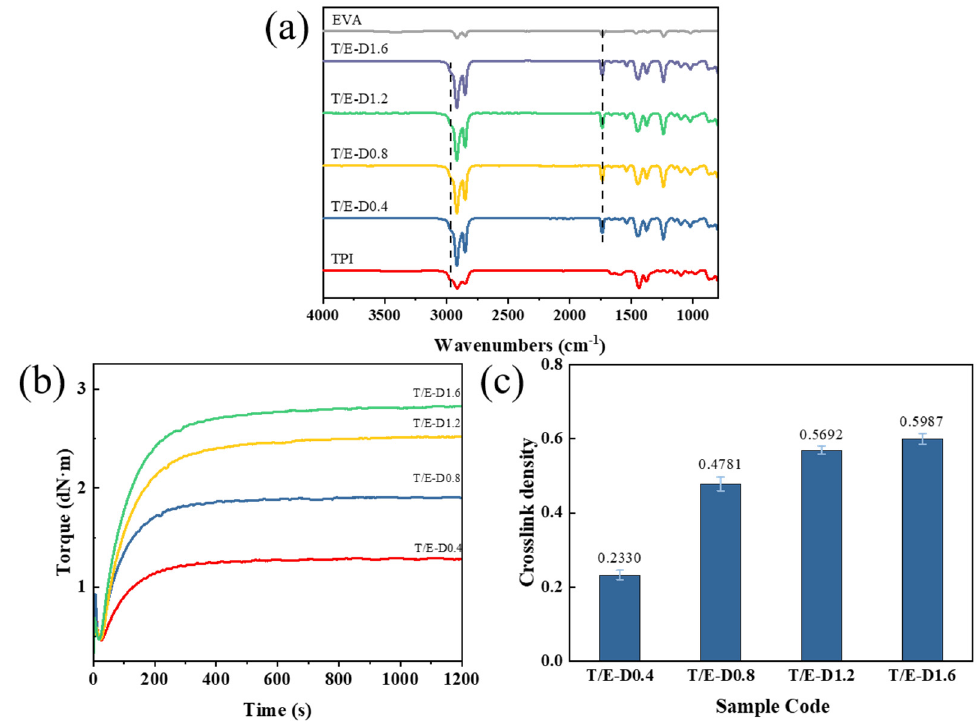
Figure 1. ( a ) FT-IR spectra of the toluene-extracted TPI/EVA composites; ( b ) Elastic torque of TPI/EVA with different contents of DCP at 175 °C, and ( c ) Column plots of crosslink density of toluene-extracted TPI/EVA composites with different contents of DCP.